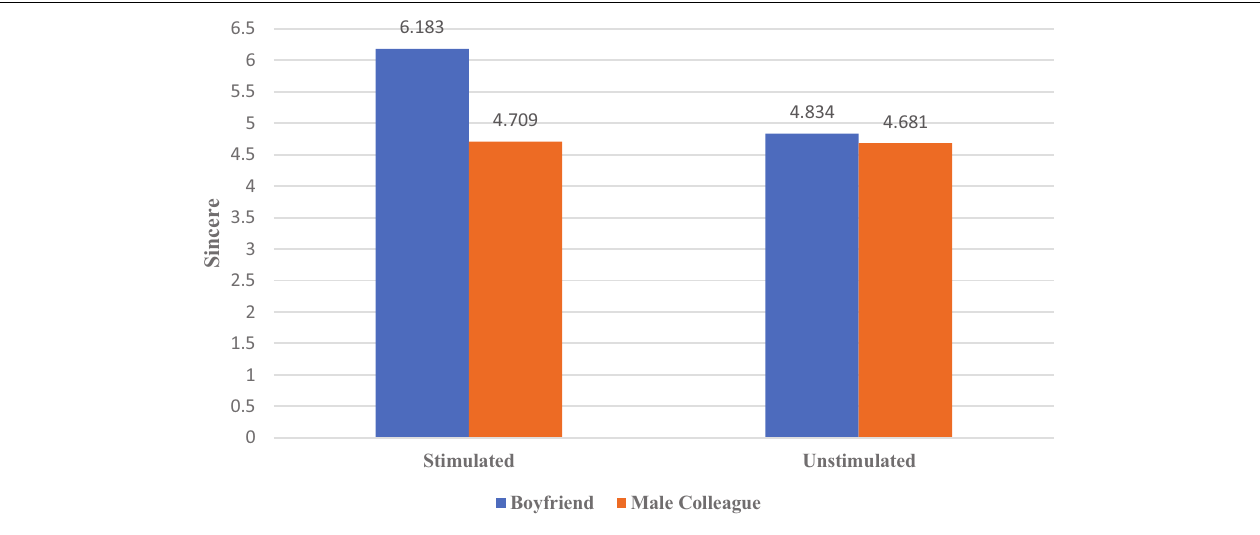
FIGURE 5 | The effect of erotic stimulation on women’s perception of the sincere personality of different owners’ possessions.